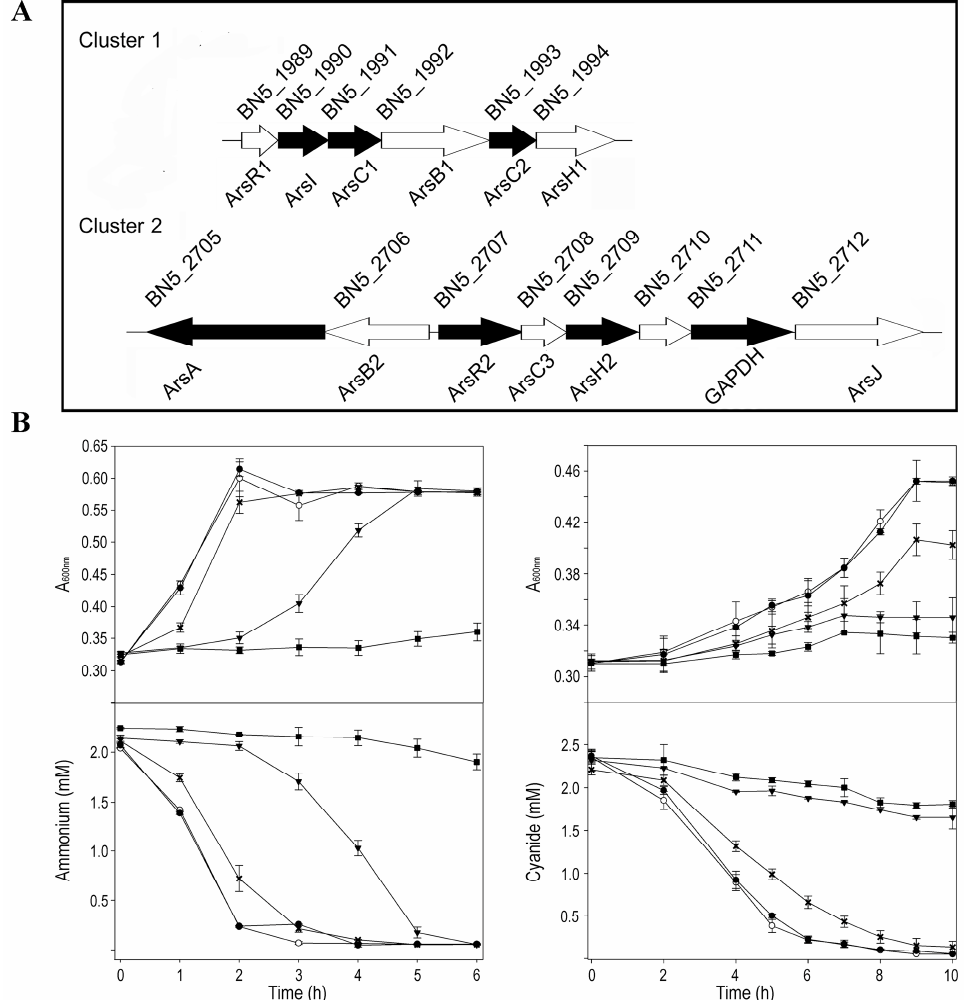
Figure 1. P. pseudoalcaligenes CECT 5344 ars gene clusters and physiological characterization of arsenic tolerance. ( A ) Genes coding for putative proteins related to arsenic detoxification. The reference numbers correspond with UniProt annotation (UP000032841). Black genes code for proteins identified by LC-MS/MS proteomic analysis in cells grown in the presence of arsenite. Gene descriptions are provided in Supplementary Data Set S1 (SDS1). ( B ) Arsenite tolerance of the strain CECT 5344. Cells were grown in M9 minimal medium with 50 mM sodium acetate as carbon source and 2 mM ammonium chloride (panels left) or 2 mM sodium cyanide (panels right) as nitrogen source, without (open circles) or with arsenite 0.1 mM (filled circles), 0.25 mM (asterisks), 0.5 mM (filled triangles), and 1 mM (filled squares). Bacterial growth, upper panels; N-source consumption, lower panels.